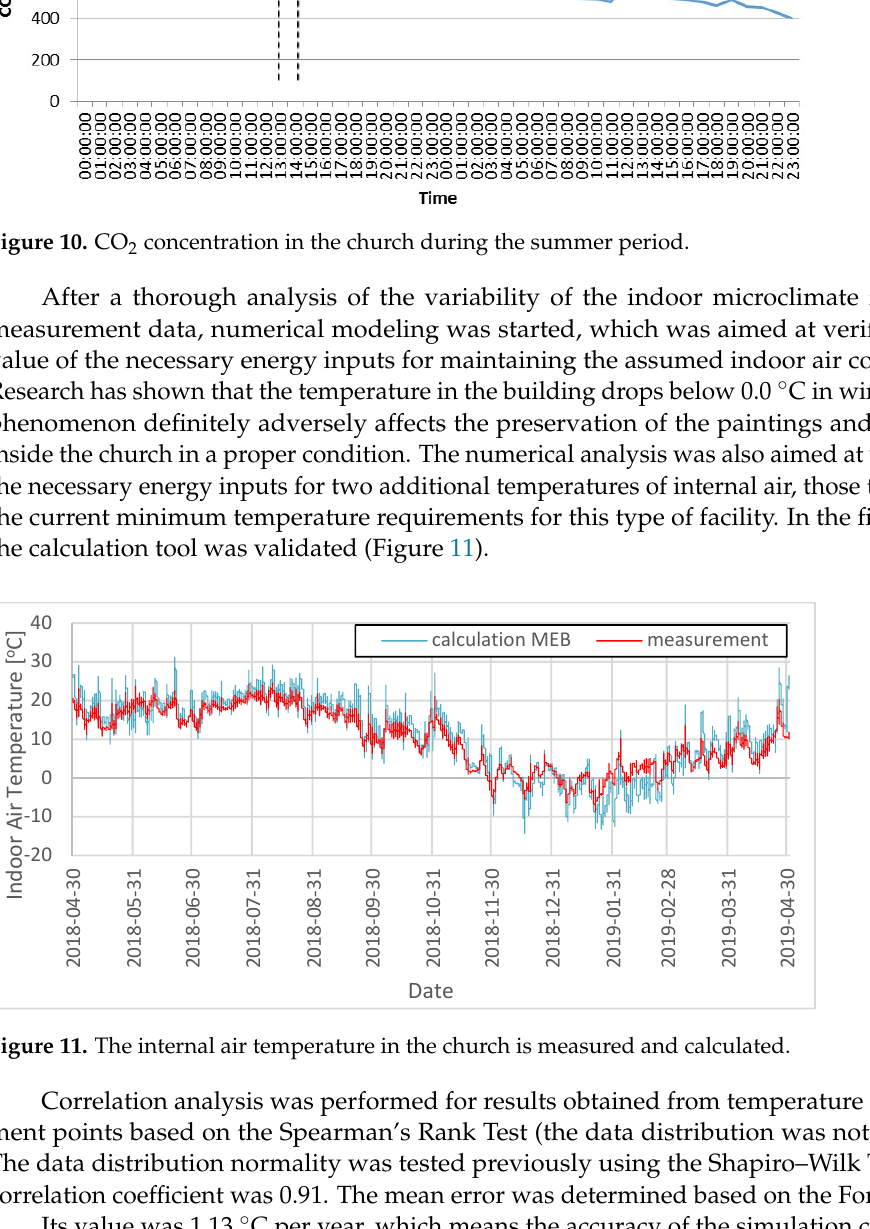
Figure 9. CO 2 concentration during the service in winter time.